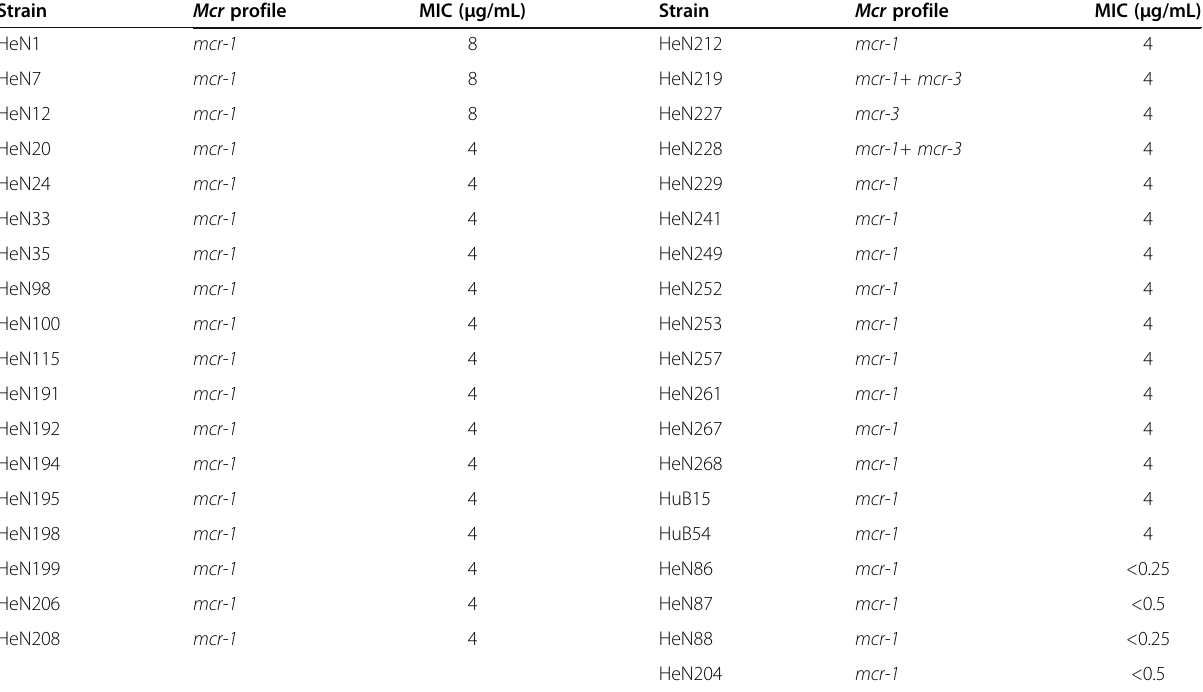
Table 1 Minimum inhibitory concentration (MIC) values for colistin of 37 mcr -positive E. coli isolates